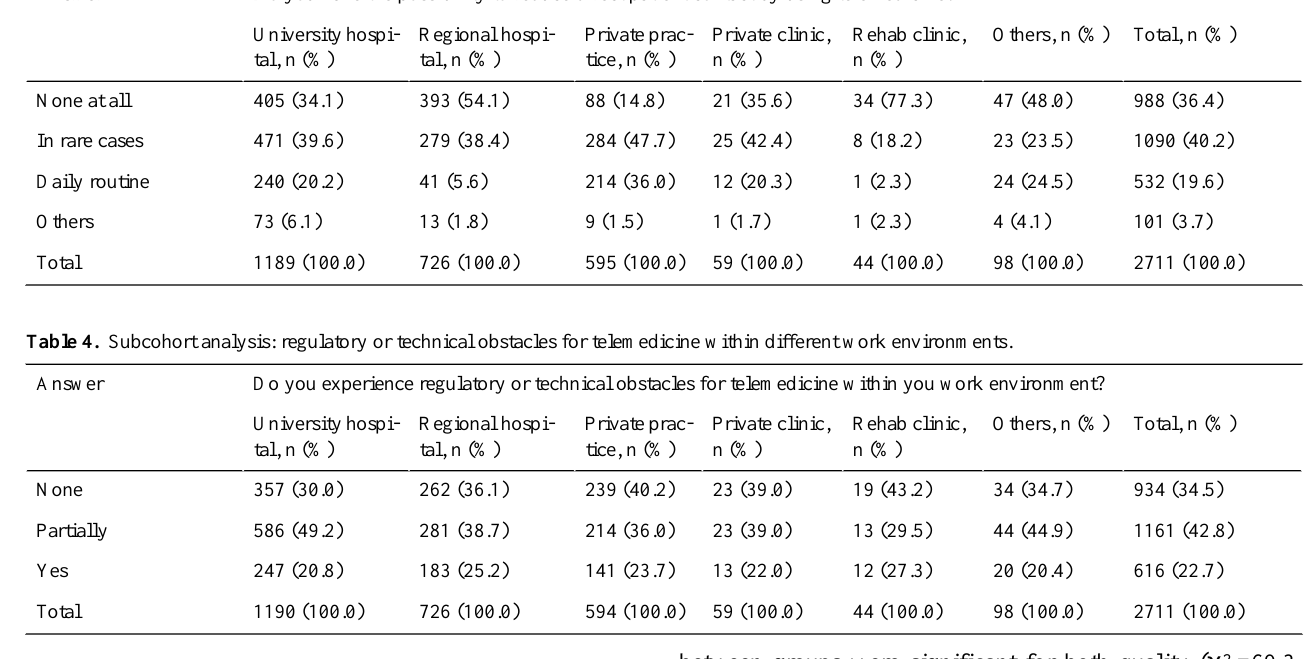
Total, n (%)Others, n (%)Rehab clinic,